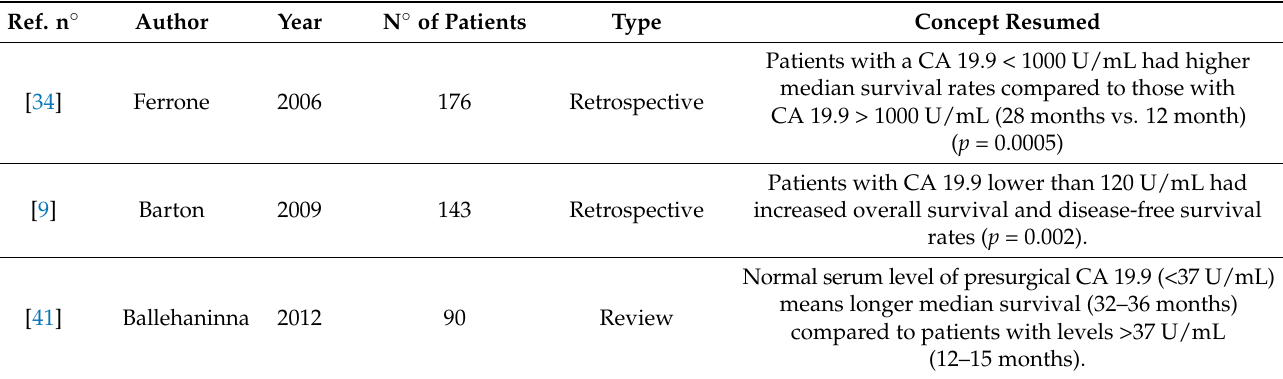
Table 5. Literature review on relationship between CA 19.9 and overall survival